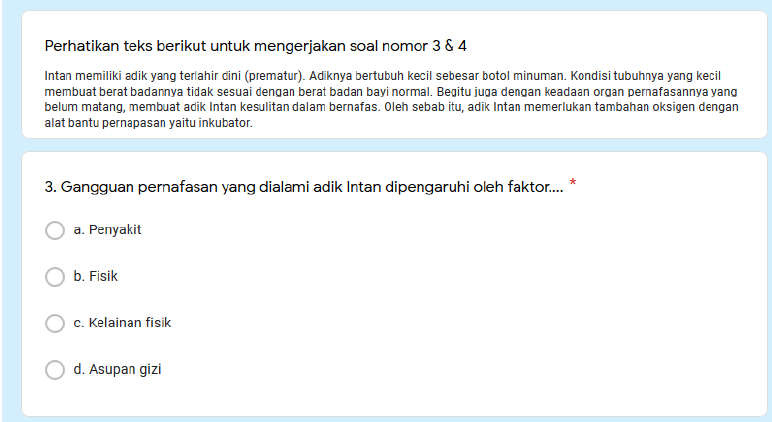
Figure 10. Problem-solving question number 3, Package